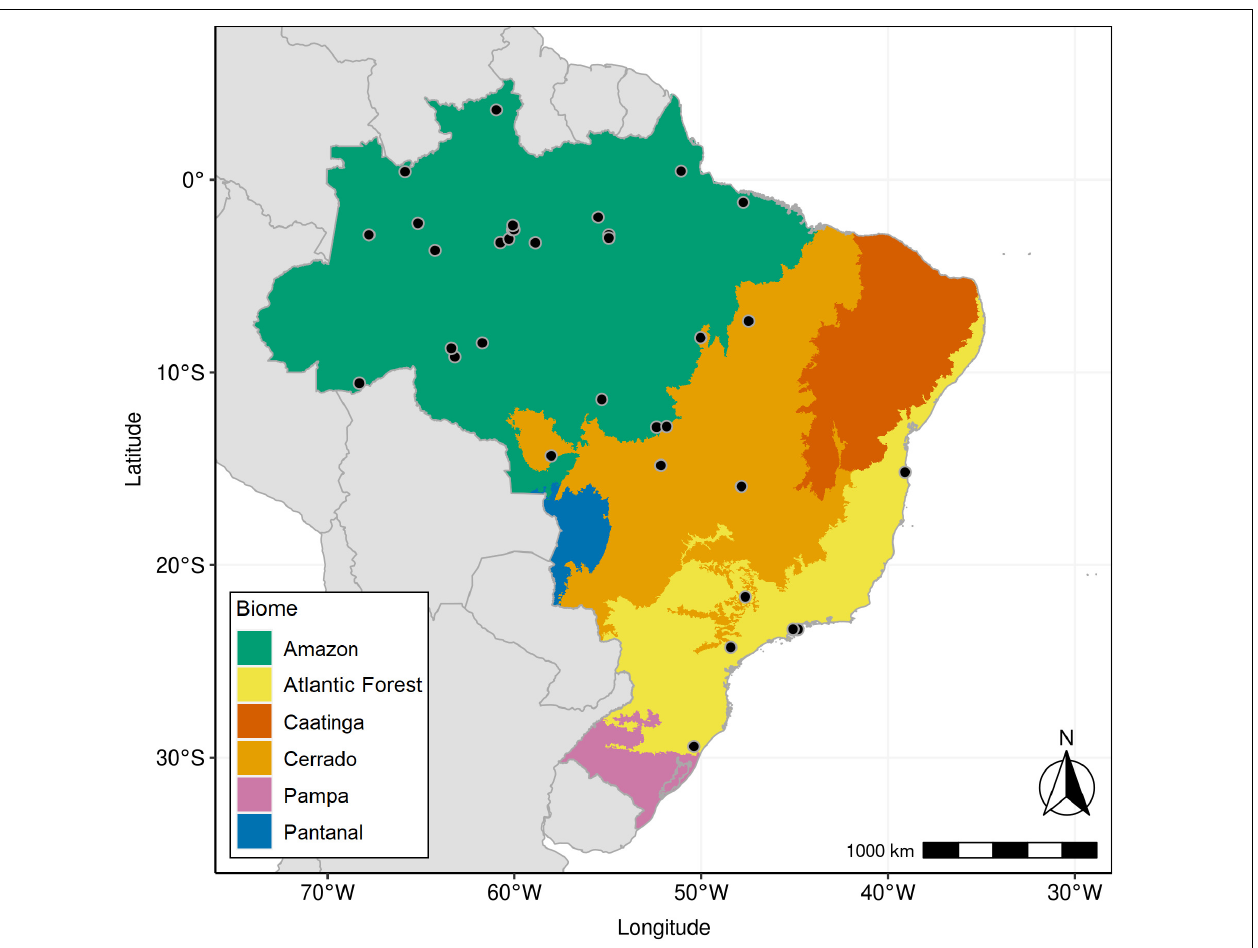
FIGURE 1 | Map of Brazil with borders of its six major continental biomes: Amazon, Atlantic Forest, Caatinga, Cerrado, Pampa, and Pantanal. Black circles indicate sampling plots included in this